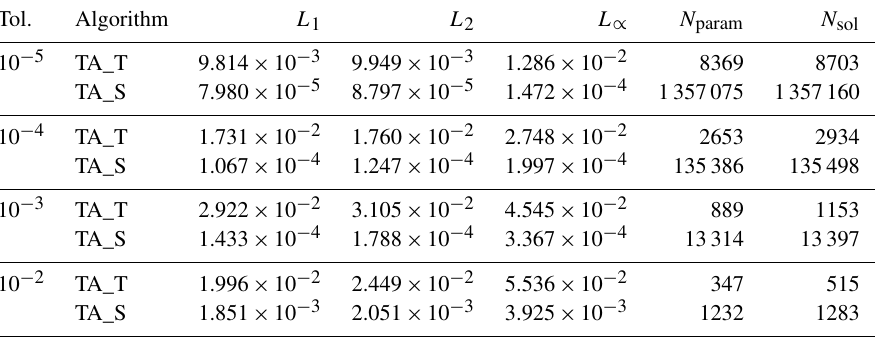
Table 8. Relative errors and number of iterations obtained for the time-adaptive algorithm depending on different convergence criteria for TC3.